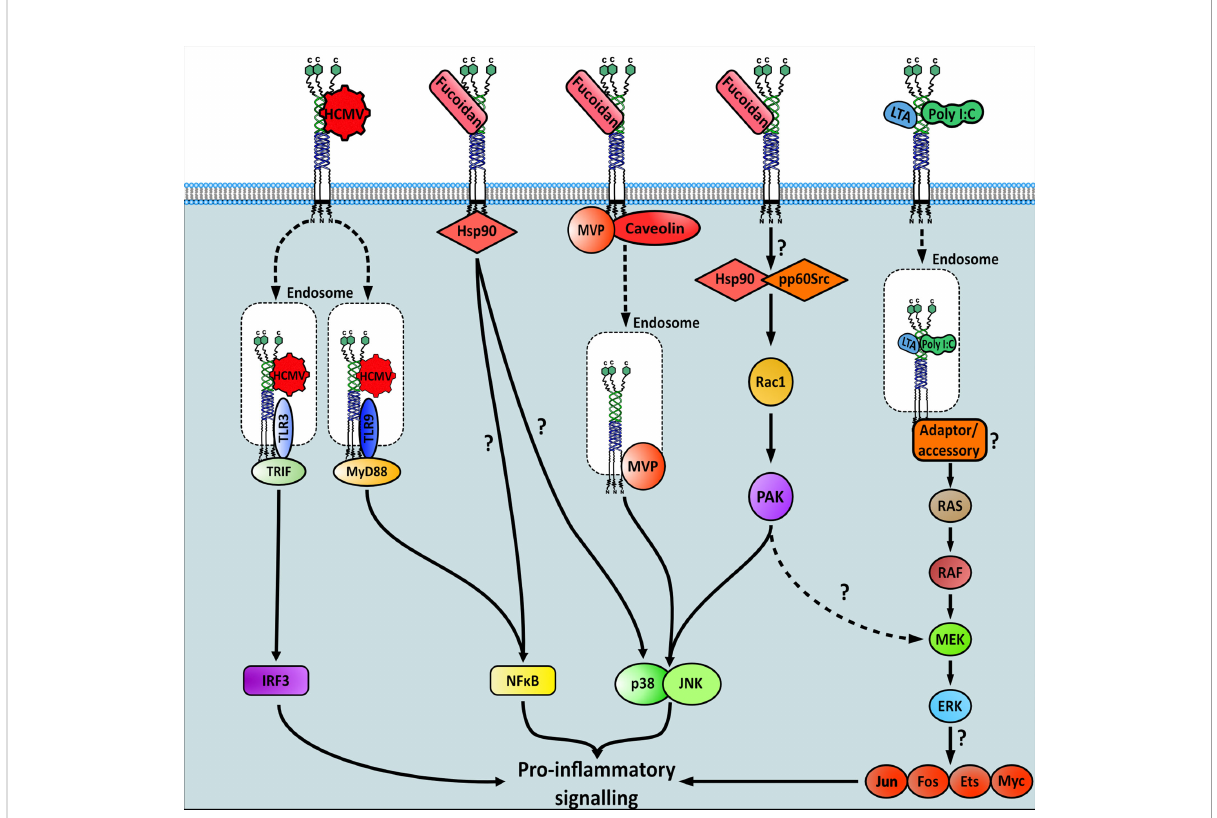
FIGURE 6 Signalling pathways downstream of MSR1 initiated after speci fi c ligand binding. Question marks within the fi gure highlight gaps in the knowledge regarding each